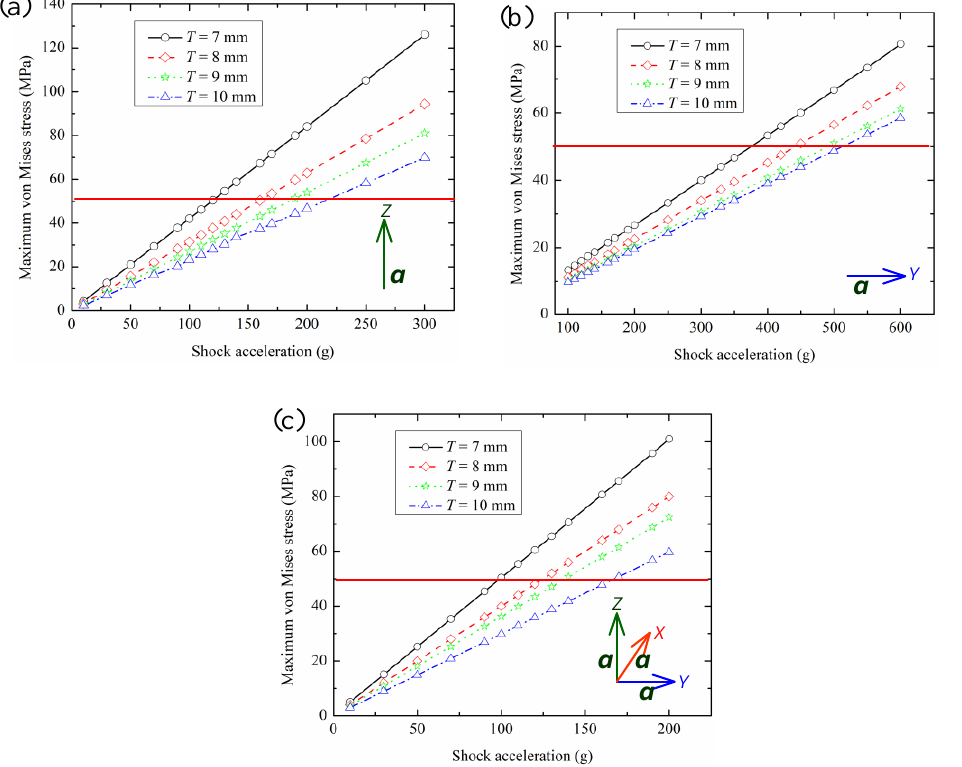
Figure 3. Variation of σ von-Mises as a function of the shock acceleration and the thickness T of the mid-plane as well as loading along the three directions: ( a ) Vertical direction ( Z -axis). ( b ) Horizontal direction ( Y -axis). ( c ) Three orthogonal directions ( X -axis, Y -axis, and Z -axis). The black solid line with circles, red dashed line with squares, green dotted line with stars, and blue dash-dot line with triangles correspond to T equal 7 mm, 8 mm, 9 mm, and 10 mm, respectively. The red line represents the ultimate tensile stress σ max of the material ULE of the USOC.